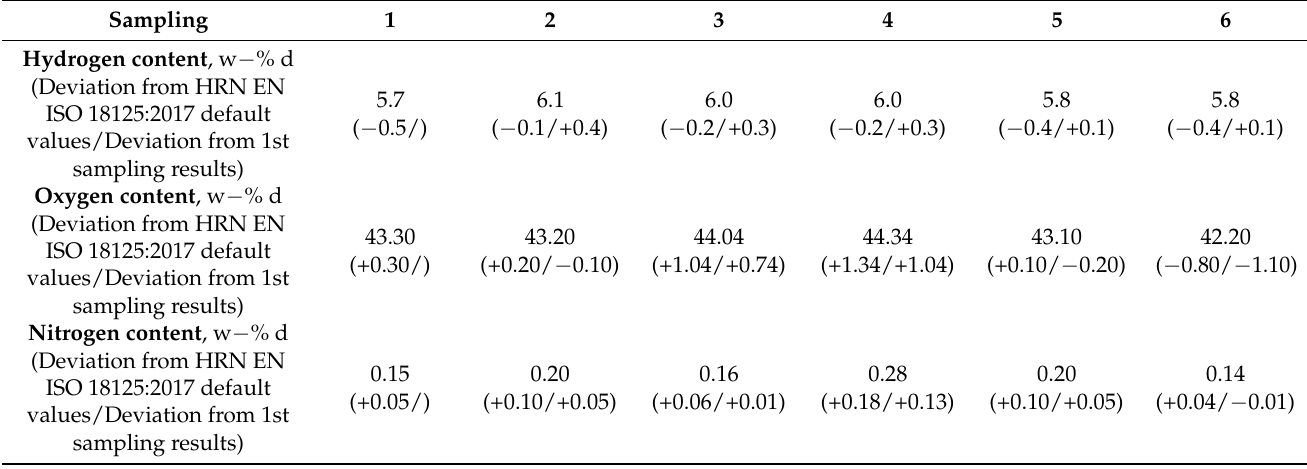
Table A2. Results of the CHN(S) analyses of beech energy wood.